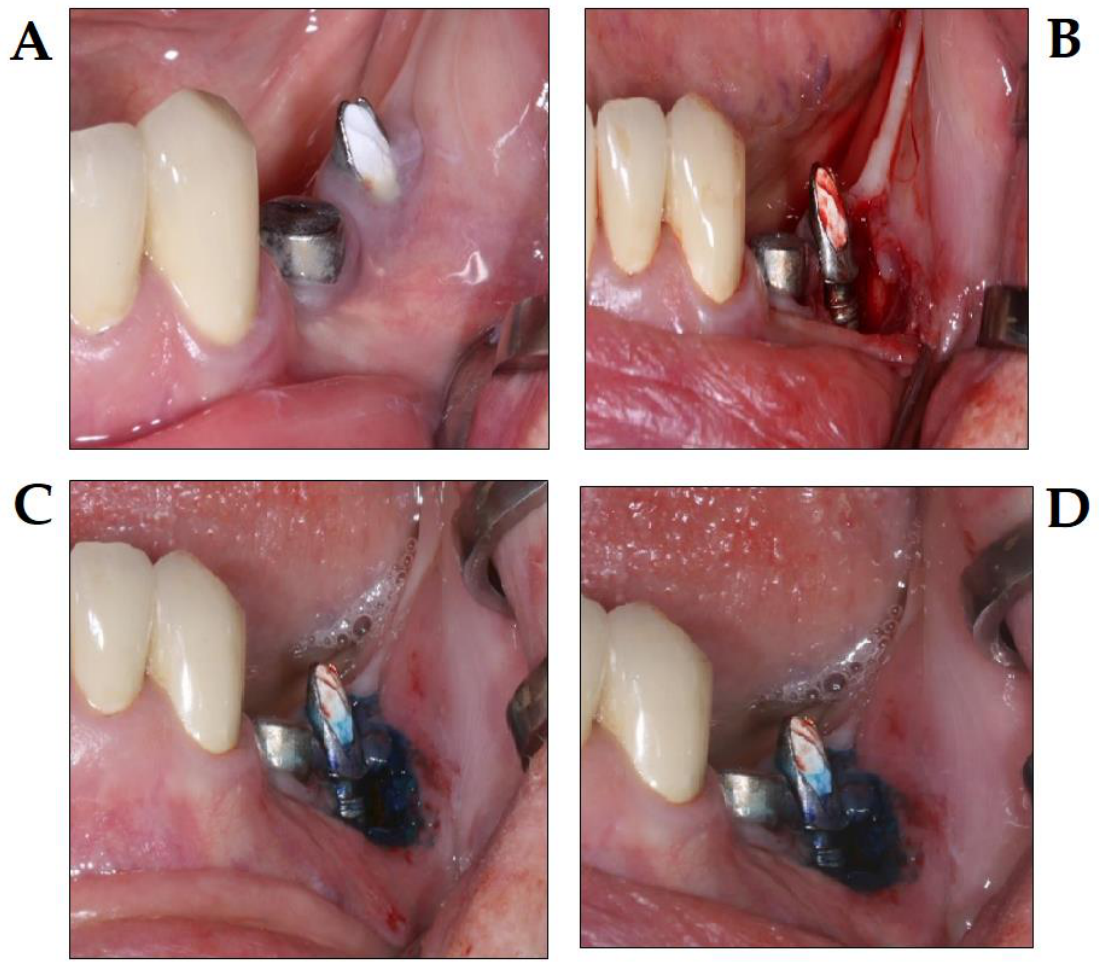
Figure 8. PDT in the treatment of periimplantitis, using the Photolase ® PDT system (photo courtesy of Z. Baráth DMD PhD). A : Initial stage peri-implantitis; B : surgical flap elevation; C : application of photosensitizer after surgical debridement; and D : conditions directly after the diode laser therapy.